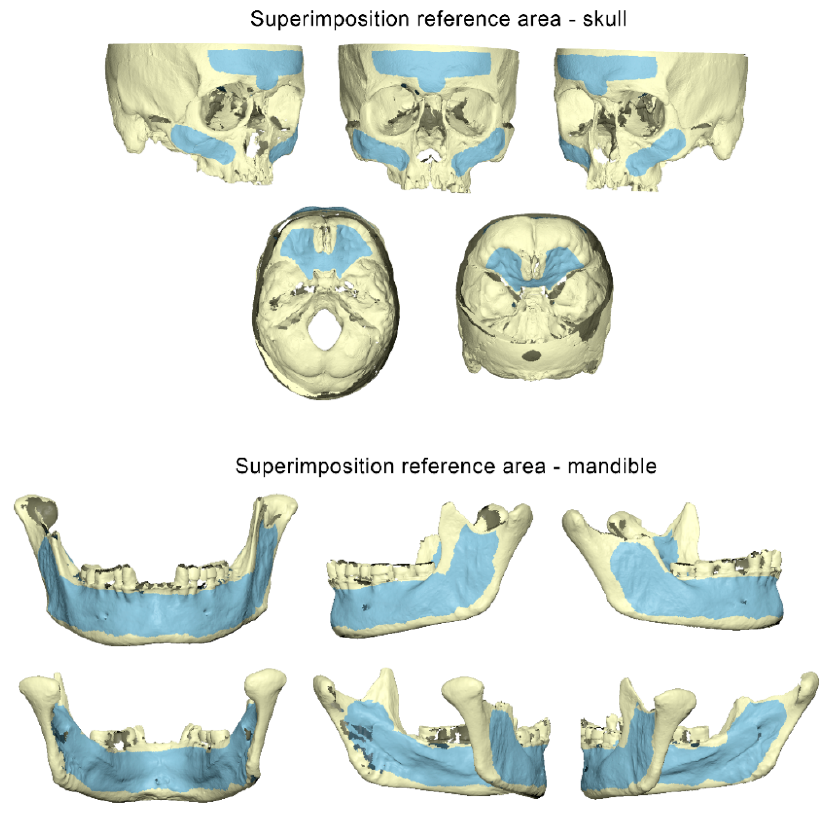
Figure 2. Superimposition reference areas used in the skulls and mandibles ( top : buccal aspect, bottom : lingual aspect) to register corresponding 3D surface models, depicted in light blue color. Ten measurement areas were defined in each skull, consisting of 10,000 triangles each. These were located at the middle, the right, and the left side of the forehead, at the right and left side of the zygomatic process, at the right and left side of the maxillary complex, at middle part of the sphenoid bone, and the right and left sides of the anterior cranial base (Figure